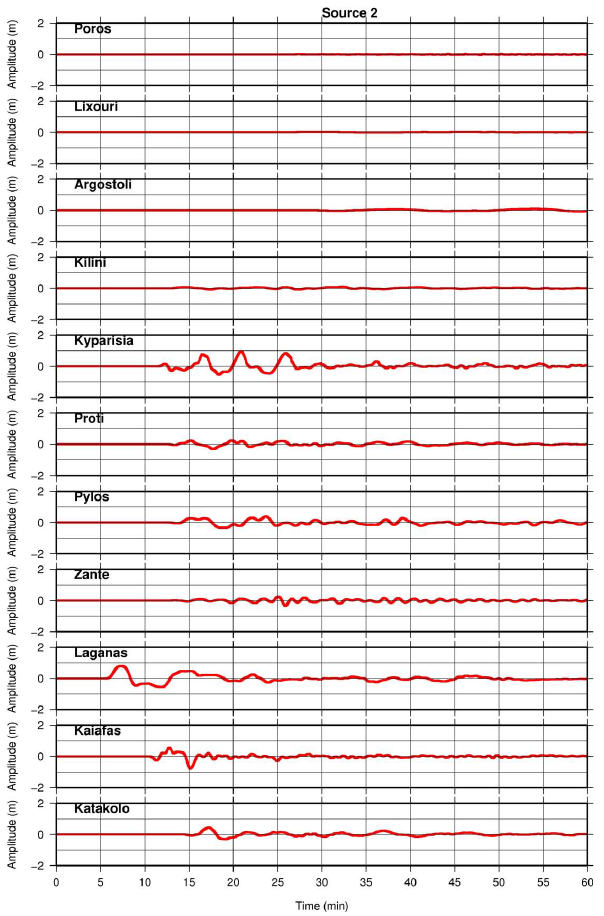
Fig. 7. Calculated mareograms at the locations shown in Fig. 4, for source 2 (Zakynthos fault).